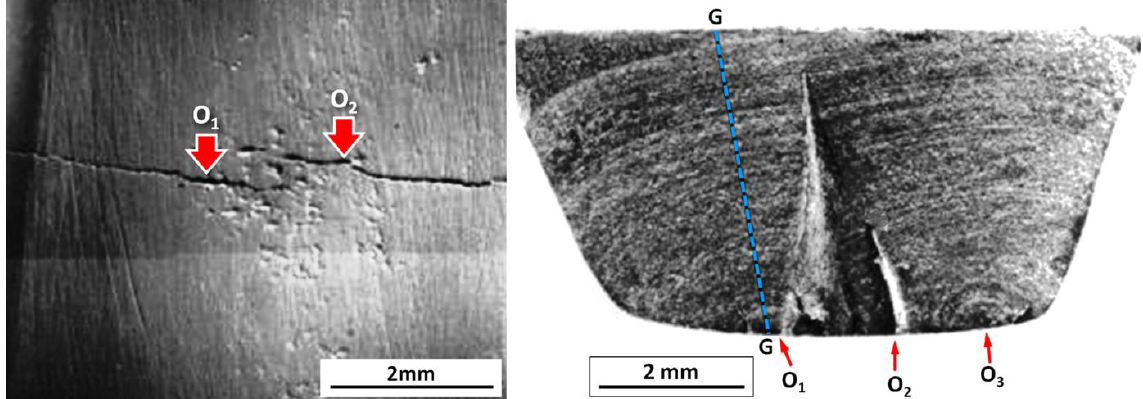
Figure 15 . SEM and optical images of corrosion pitting and fatigue in a D6ac high-strength steel stiffener runout from aircraft A8-148 48. There were three fatigue nucleation sites, O 1 , O 2 , O 3 . The line G‒G indicates the track chosen for QF measurements. Reprinted with permission from [48]. Copyright 1998 DST.